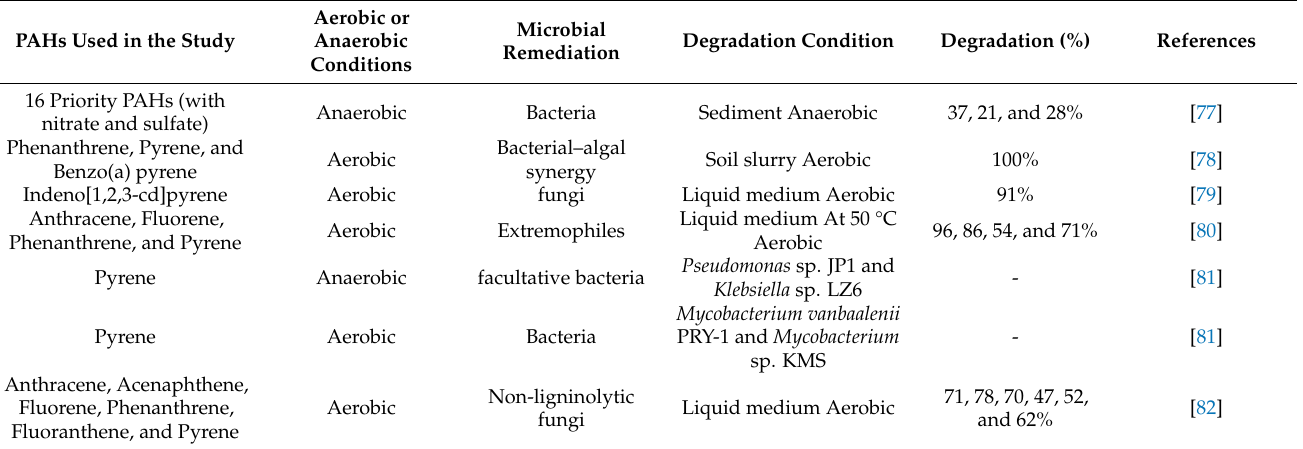
Table 3. Bioremediation by microorganisms of polycyclic aromatic hydrocarbons in aerobic and anaerobic